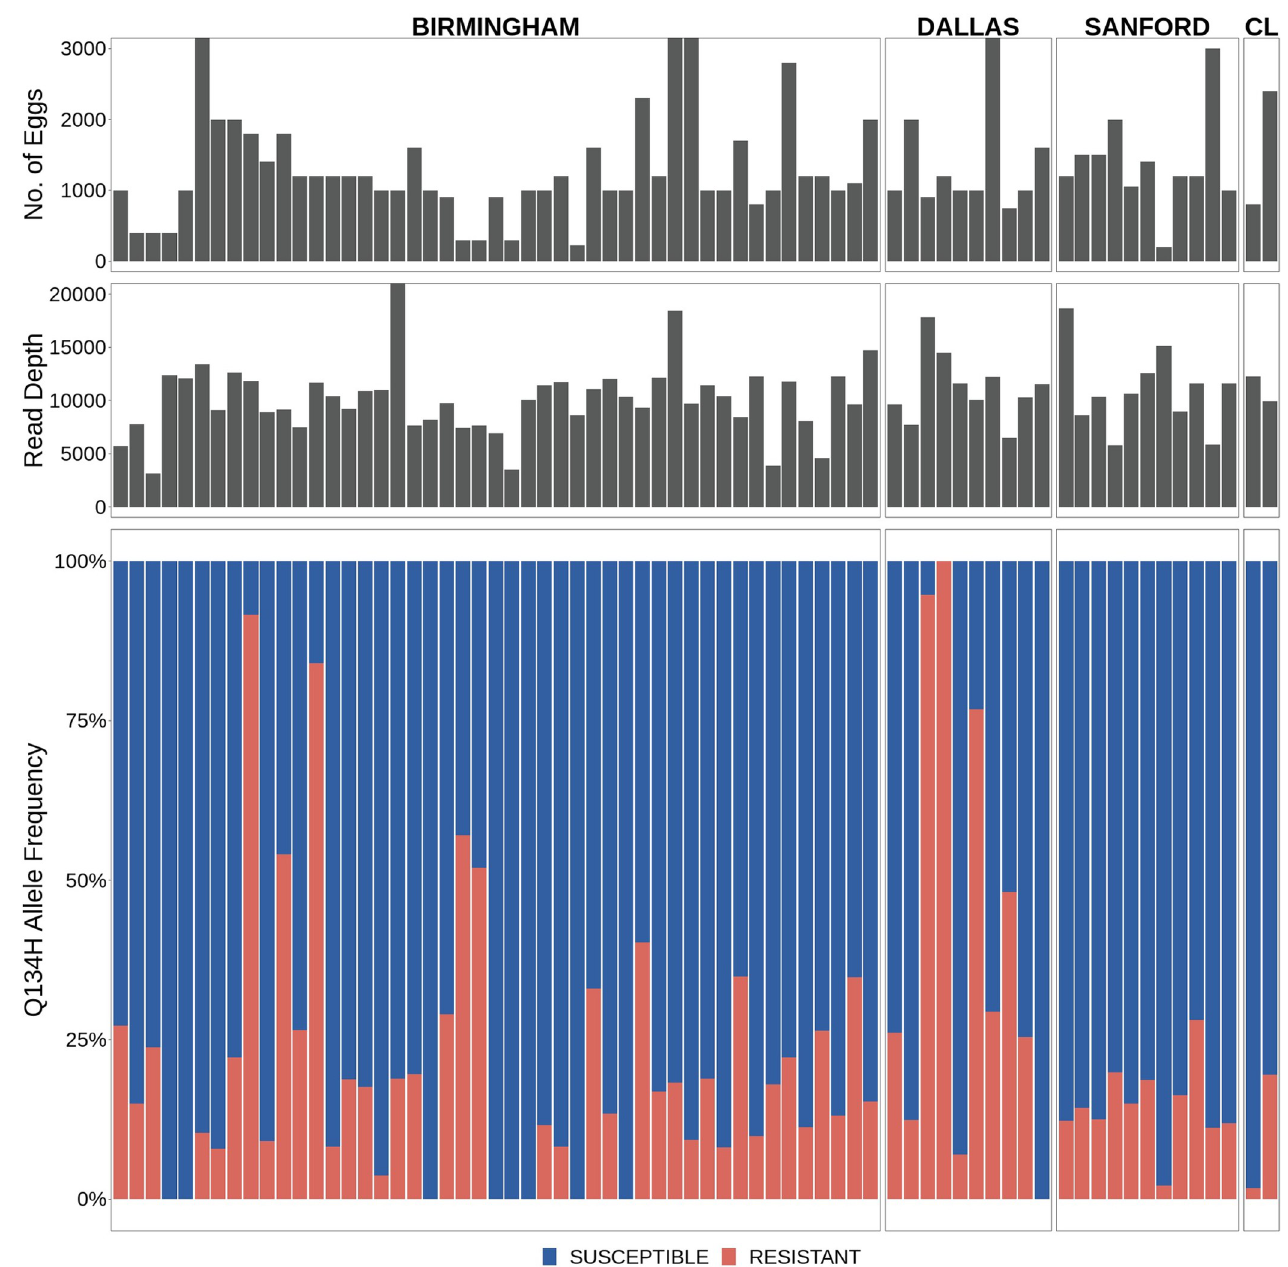
Fig 6. Frequency and prevalence of the novel Q134H(CAA > CAT) benzimidazole resistance mutation in A . caninum infecting greyhounds in the USA. Deep amplicon sequencing data of the 293 bp isotype-1 β -tubulin fragment for A . caninum from greyhounds in adoption kennels in four locations in the USA [12]. The top panel is a bar chart showing the number of eggs used to make each genomic DNA preparation, in the middle is a bar chart showing the mapped read depth for each sample, and the lower chart shows the relative frequency of the Q134H(CAA > CAT) mutation. Red bars indicate the 134H(CAT) resistance allele and the blue bars indicate the 134Q(CAA) susceptible